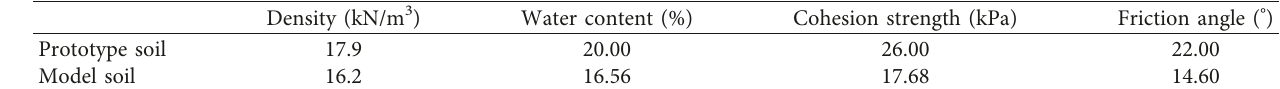
Figure 3: Model structure: (a) prefabricated utility tunnel model; (b) pipeline model hold by the tunnel. Table 2: Physical properties of model soil.